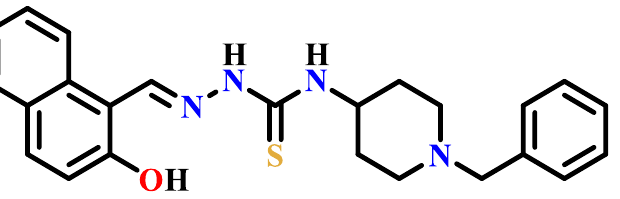
Figure 61. The chemical structure of NBPT containing naphthylhydrazone moiety.